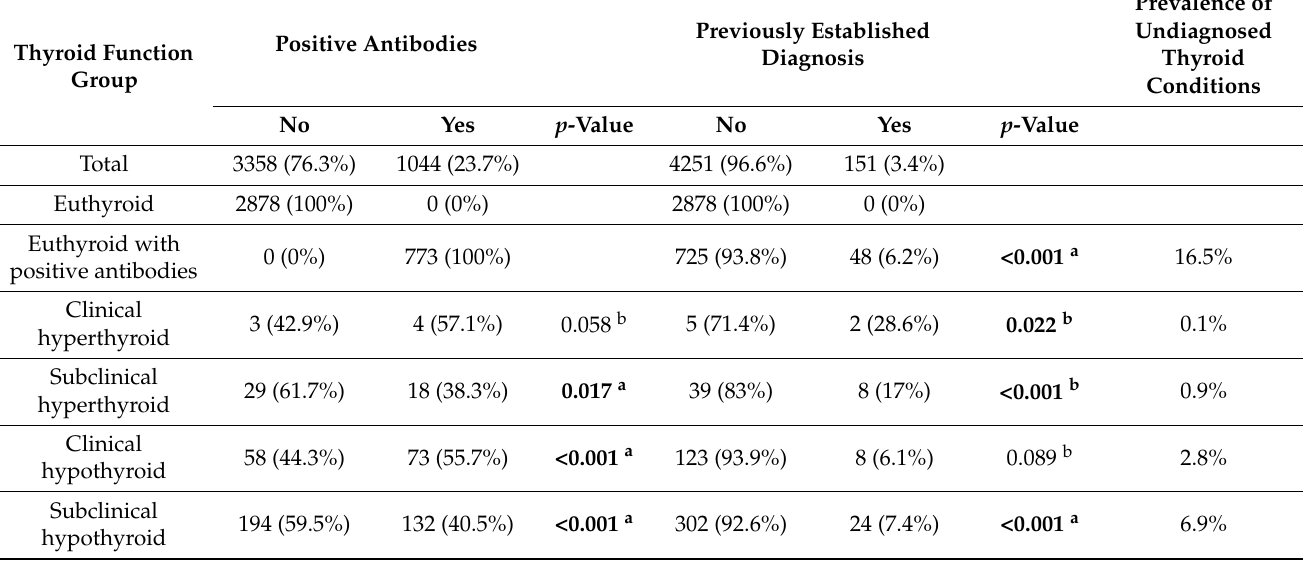
Table 4. Differences within thyroid function groups according to positive antibodies and previously established diagnosis, and prevalence of undiagnosed thyroid